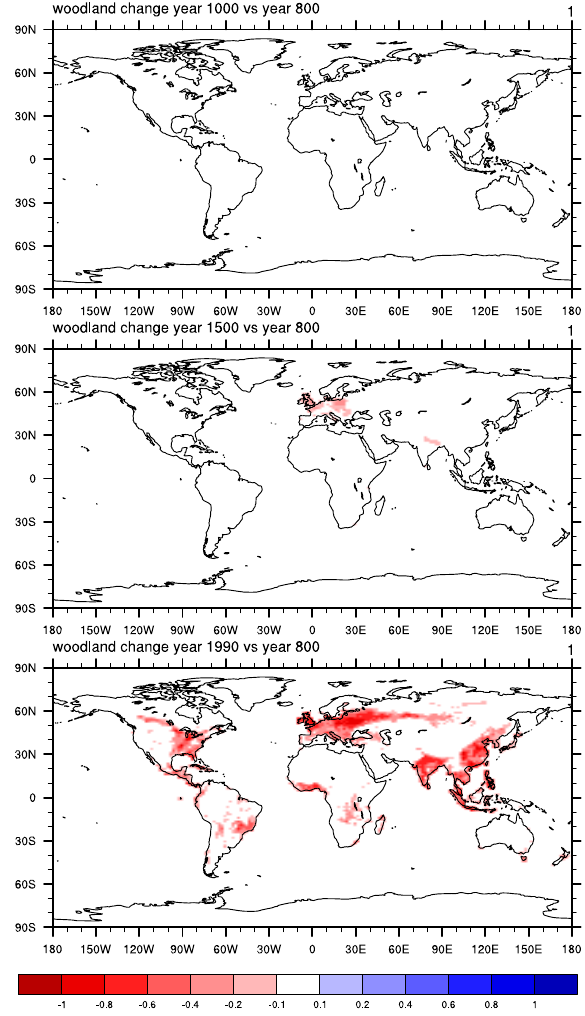
Fig. 17. Changes in fractional area coverage of woodland (broad leaf+needle leaf tree) in year 1000AD, 1500AD and 1990AD with respect to the year 800AD. Data from Pongratz et al. (2008) regrid- ded on HadGEM2-ES